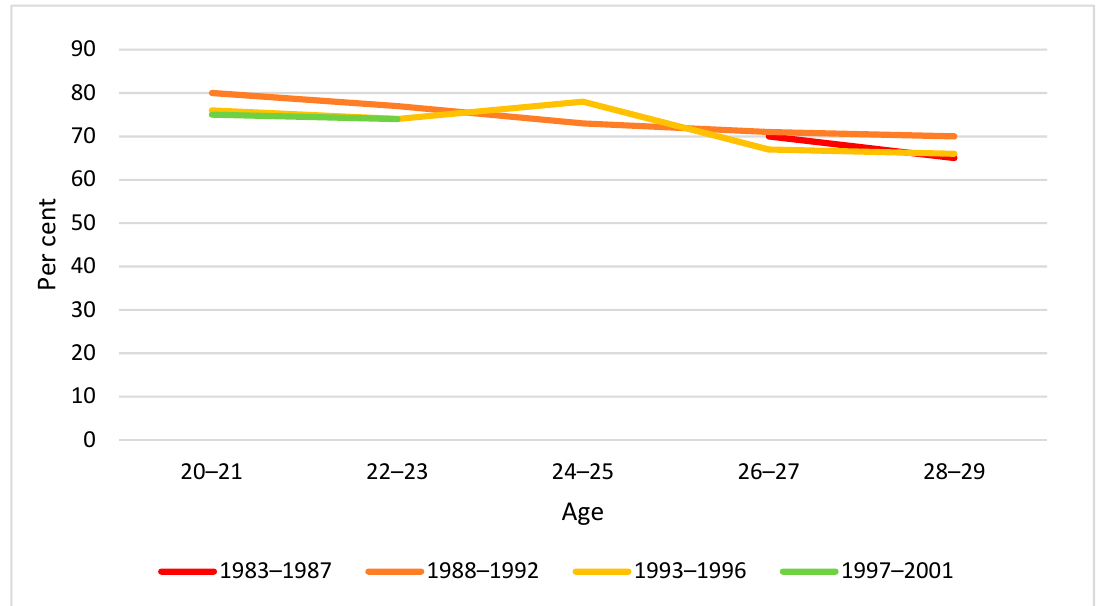
Figure 5. Past year HED prevalence by age and birth cohort. Note: None of the cohort differences at any age were statistically significant ( p > 0.05).